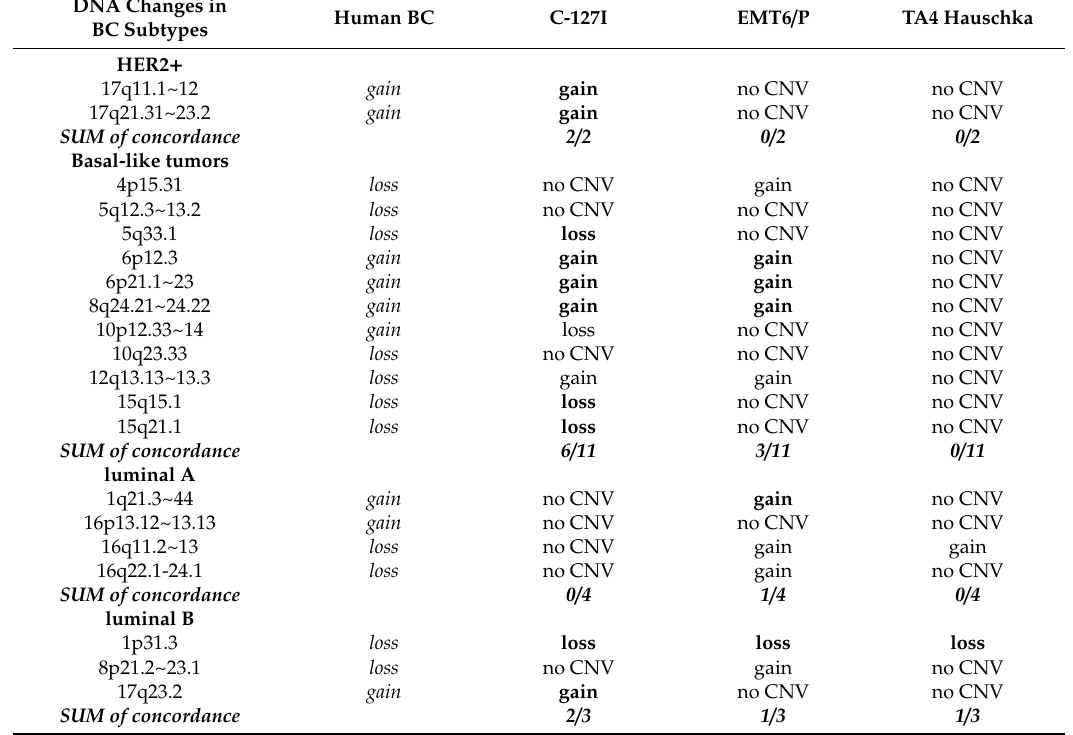
Table 4. Copy number changes associated with molecular subtypes of human BC, according to [27], with the copy number variants (CNVs) in cell lines C-127I, EMT6 / P and TA3 Hauschka: Concordances with human CNVs (in italics) are highlighted in bold. Abbreviations: no CNV = no copy number variants. DNA Changes in BC